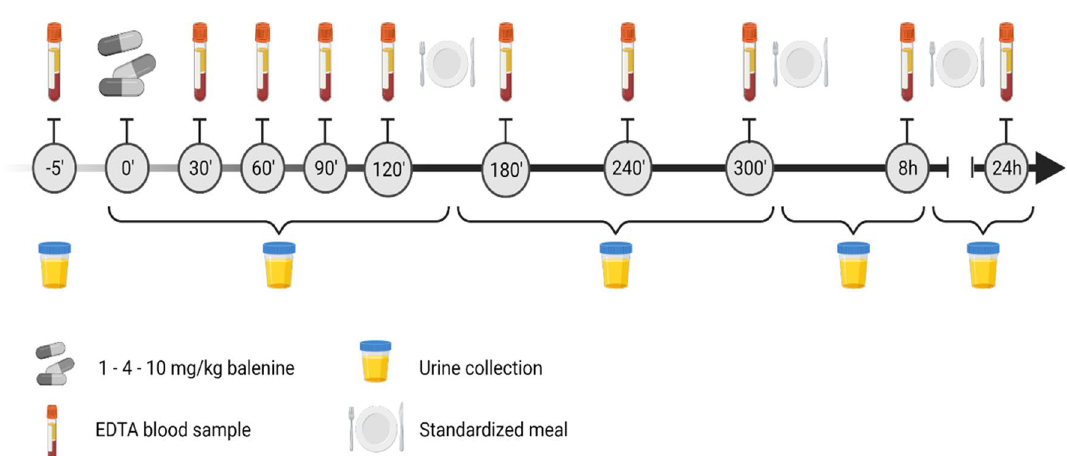
Figure 5. Timeline of a test day (Figure created with